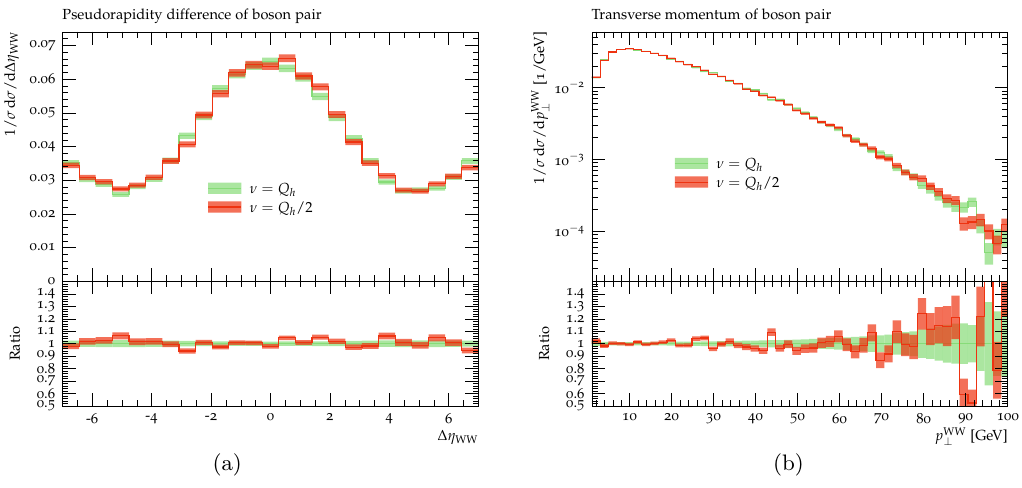
Figure 19 . (a) Di(cid:11)erence between the pseudorapidities of the W bosons. (b) Transverse momentum of the WW pair.